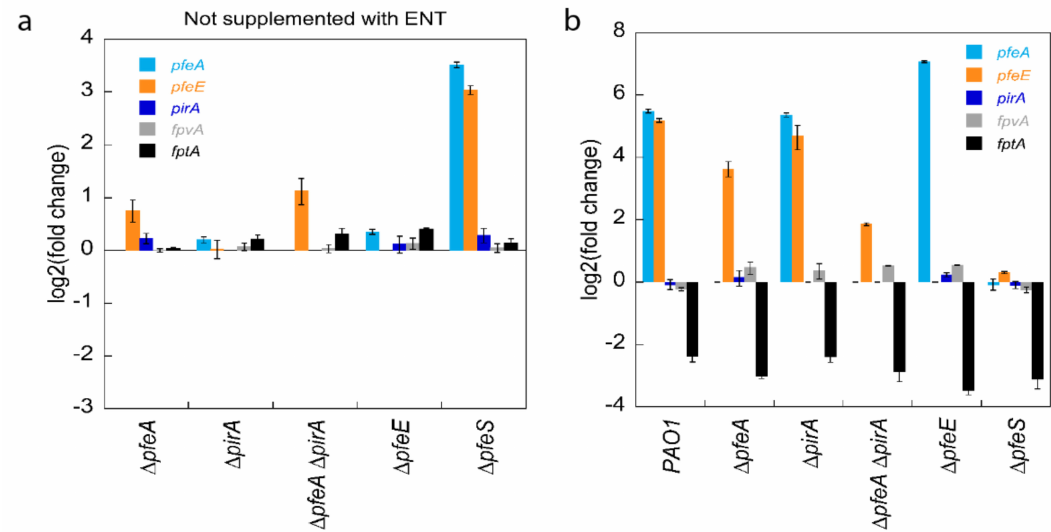
Figure 2. Analysis of changes in the transcription of the pfeA, pfeE, pirA, fpvA and fptA genes. RT-qPCR was performed on RNA isolated from P. aeruginosa PAO1 cells and the corresponding ∆ pfeA , ∆ pirA , ∆ pfeA ∆ pirA , ∆ pfeE , and ∆ pfeS mutants, grown for 8 h in CAA medium. The results in panel ( a ) are given as the ratio between the values obtained for the various mutants ( ∆ pfeA , ∆ pirA , ∆ pfeA ∆ pirA , ∆ pfeE and ∆ pfeS ) over those obtained for PAO1, all grown in the absence of ENT. pfeA and pirA encode TBDTs involved in ENT-Fe uptake [21,23], fpvA , the TBDT of PVD-Fe [30], and fptA of PCH-Fe [31] (Table S1 in the Supplementary Materials). The results in panel ( b ) are given as the ratio between the values obtained for the various strains in the presence of ENT over those obtained for the same strains in the absence of ENT. For both panels ( a , b ), the data are normalized relative to the reference gene uvrD and are representative of three independent experiments performed in triplicate ( n =